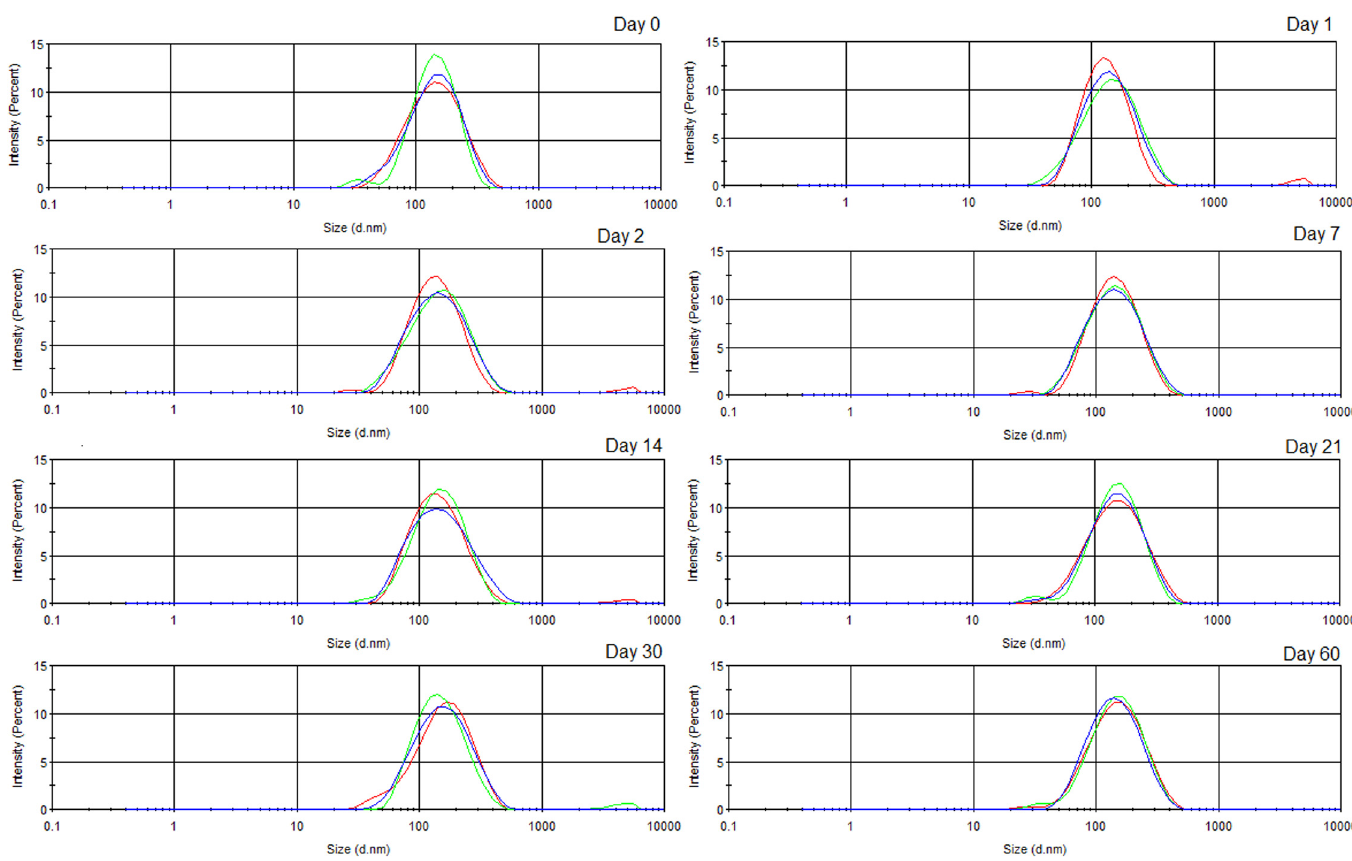
Fig 4. Mean droplet size — Day 0: 125.1 ± 0.5 nm; Day 1: 124.4 ± 0.4 nm; Day 2: 125.6 ± 0.5 nm; Day 7: 124.8 ± 0.3 nm; Day 14: 127.5 ± 0.2 nm; Day 21: 131.0 ± 0.5 nm; Day 30: 134.3 ± 0.8 nm; Day 60: 129.2 ± 1.0 nm. Polydispersity index — Day 0: 0.175 ± 0.014; Day 1: 0.185 ± 0.012; Day 2: 0.196 ± 0.006; Day 7: 0.174 ± 0.003; Day 14: 0.194 ± 0.013; Day 21: 0.192 ± 0.007; Day 30: 0.210 ± 0.006; Day 60: 0.193 ± 0.001.Zeta potential — Day 0: -30.9 ± 0.4 mV; Day 1: -29.6 ± 1.4 mV; Day 2: -29.6 ± 1.4 mV; Day 7: -33.1 ± 3.3 mV; Day 14: -35.4 ± 2.8 mV; Day 21: -35.4 ± 1.2 mV; Day 30: -47.1 ± 1.5 mV; Day 60: -41.0 ± 6.34 mV.